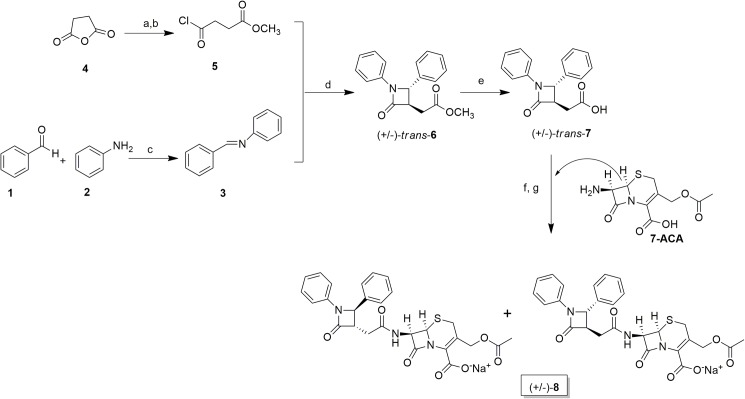
Reagents and conditions for the synthesis of compound 8.(a) MeOH, reflux; (b) SOCl2, reflux; (c) EtOH, reflux; (d) nBu3N, toluene, reflux; (e) LiOH, THF/H2O; (f) DCC, Et3N, CH2Cl2; (g) CH3COCH3, NaHCO3, H2O.